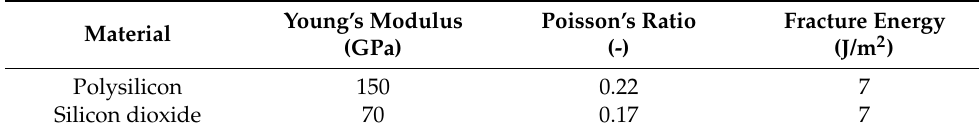
Figure 5. Confocal microscopy image of a broken stopper. Table 1. Materials properties adopted in the crack propagation simulations.